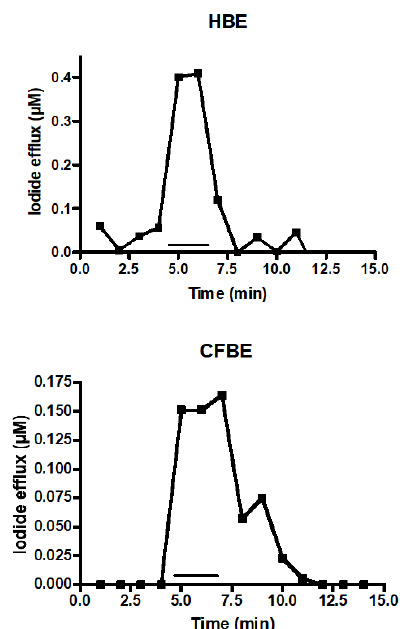
Figure 3. Citrate stimulated iodide efflux. CFTR can also export iodide instead of chloride. 16HBE14o- or CFBE41o- were loaded with iodide and the iodide concentration was measured by an iodide-sensitive electrode in 1 min intervals. The bar indicates the time period of exposure to 100 µ M of